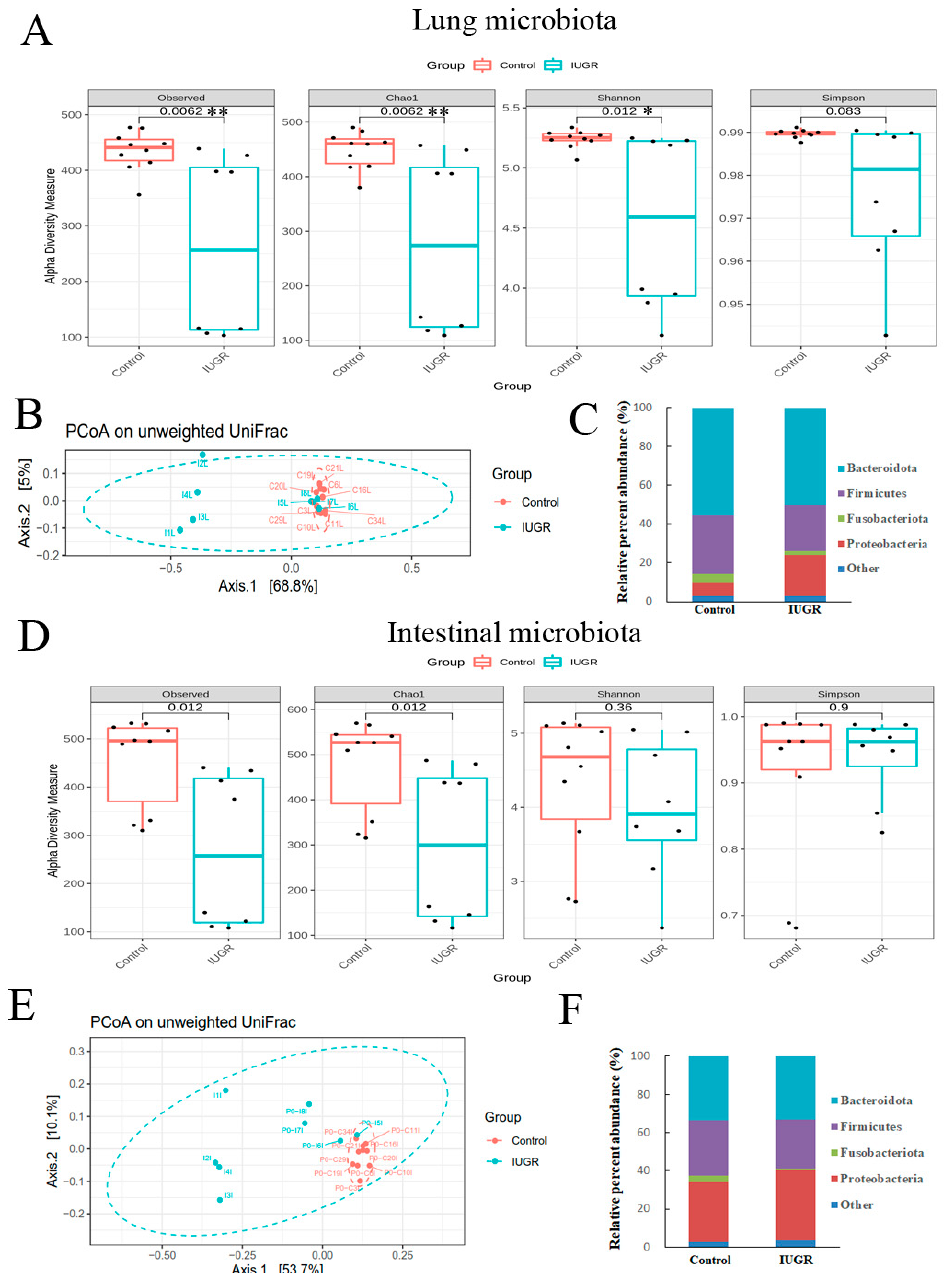
Figure 4. Effect of IUGR on the bacterial phase of offspring rats on postnatal day 0. The α -diversity indices (observed, Chao1 index, Shannon, and Simpson) in the ( A ) lungs or ( D ) gastrointestinal tract. The β -diversity (PCoA on unweighted UniFrac distances) of the ( B ) lungs or ( E ) intestinal tract and the bacterial composition at the phylum level in the ( C ) lungs or ( F ) intestinal tract. Compared with those of the control group, the lung and intestinal microbiota of the IUGR group exhibited significantly lower α -diversity and different β -diversity on postnatal day 0. n = 8–10 rats in each group. Data are shown as box-and-whisker plots. * p < 0.05, ** p < 0.01.